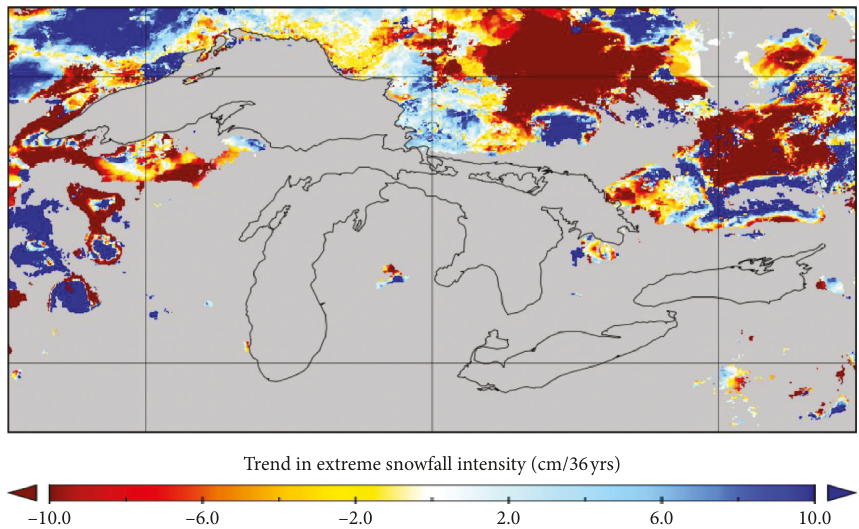
Figure 5: Trend in extreme snowfall intensity for the month of November. Gray pixels represent grid cells with no trend computed because the region contains some years with no extreme snowfall